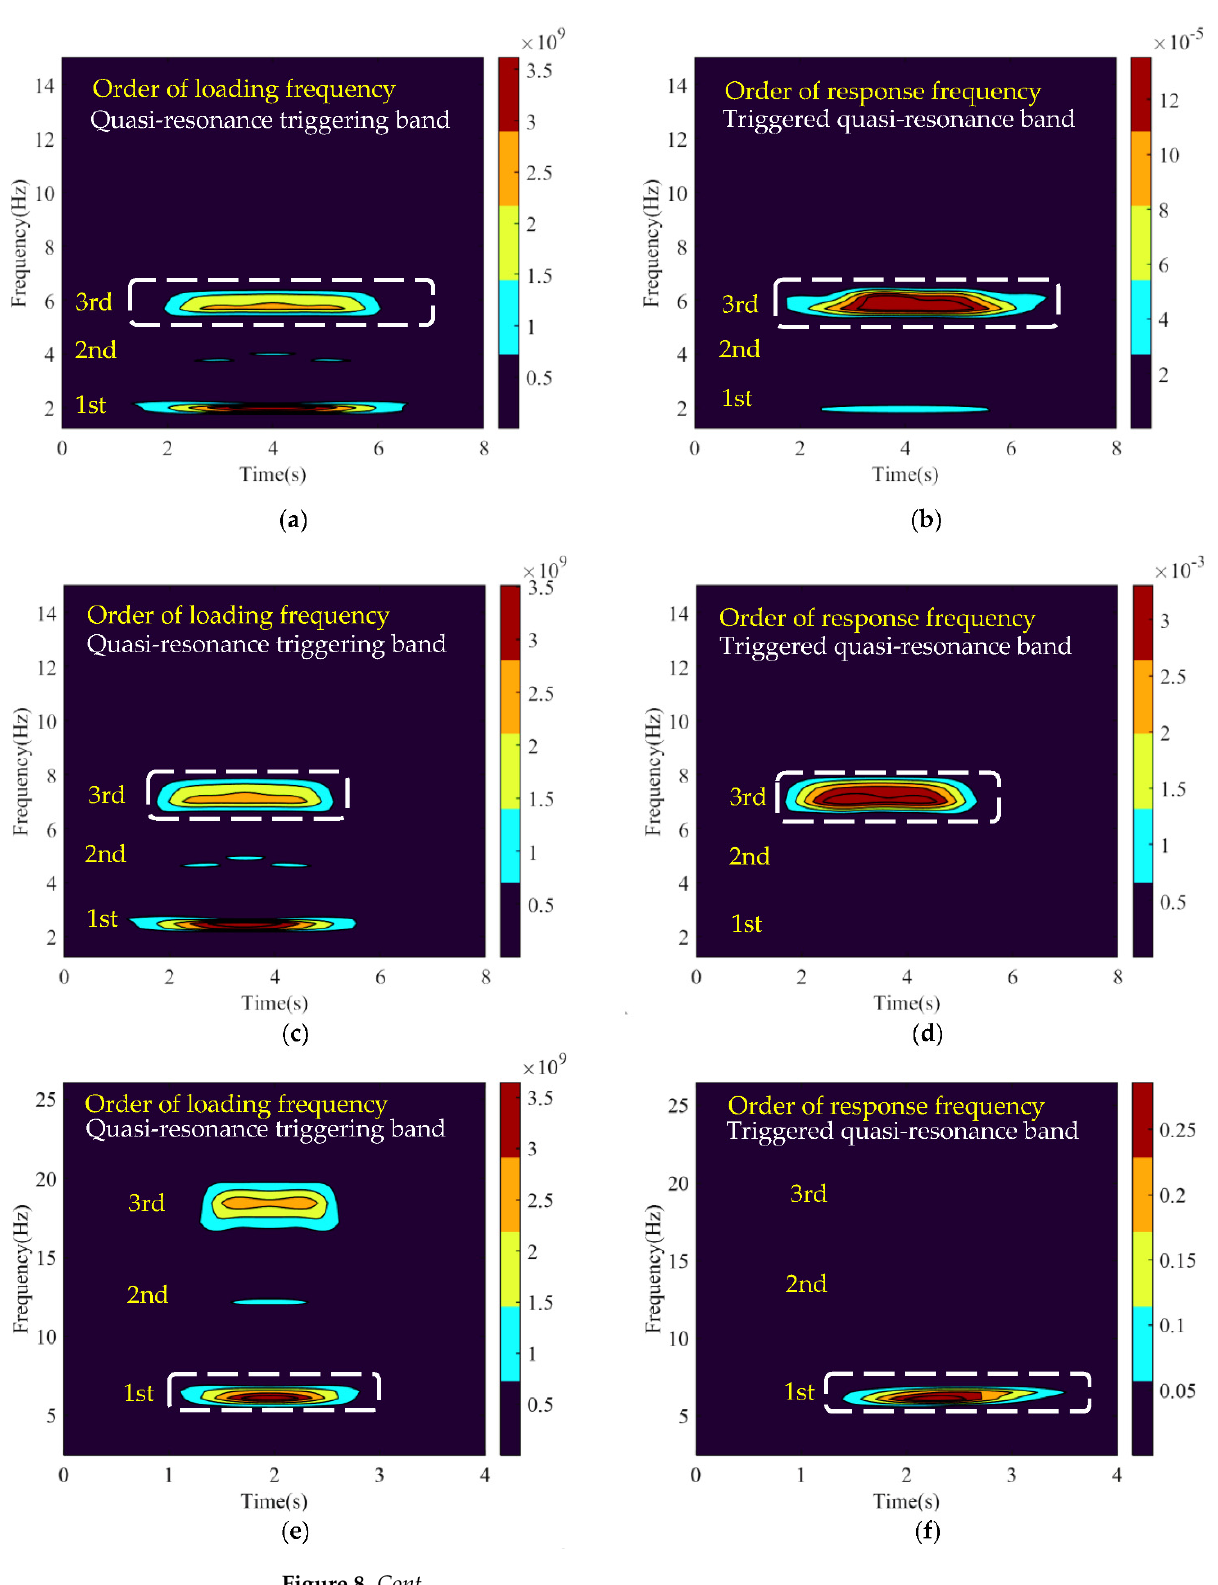
Figure 8. Scalogram from excitation to vertical vibratory resonantly transitional acceleration re- sponse at mid–span bridge: ( a ) Excitation scalogram at train speed of 175 km/h; ( b ) Bridge response scalogram at train speed of 175 km/h; ( c ) Excitation scalogram at train speed of 210 km/h; ( d ) Bridge response scalogram at train speed of 210 km/h; ( e ) Excitation scalogram at train speed of 550 km/h; ( f ) Bridge response scalogram at train speed of 550 km/h; ( g ) Excitation scalogram at train speed of 680 km/h; ( h ) Bridge response scalogram at train speed of 680 km/h.